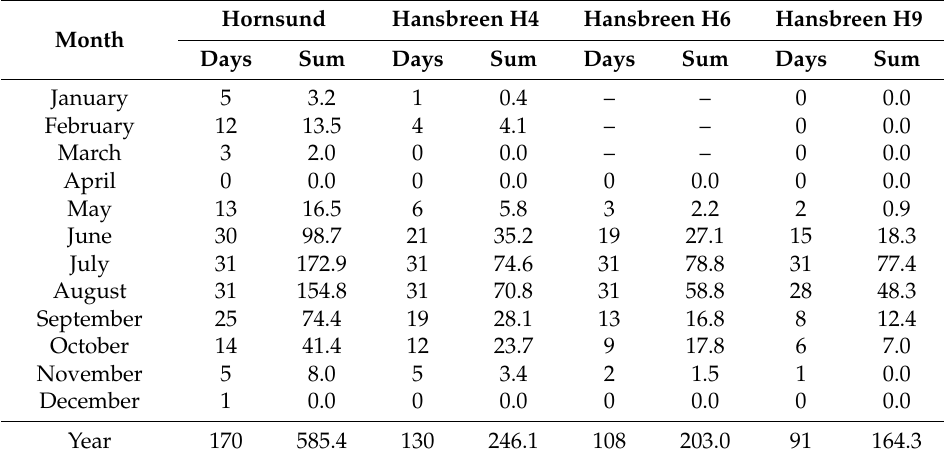
Table 2. Positive degree days (PDD) and their total in successive months of 2014 in Hornsund, on the H4, H6 and H9 Hansbreen sites.